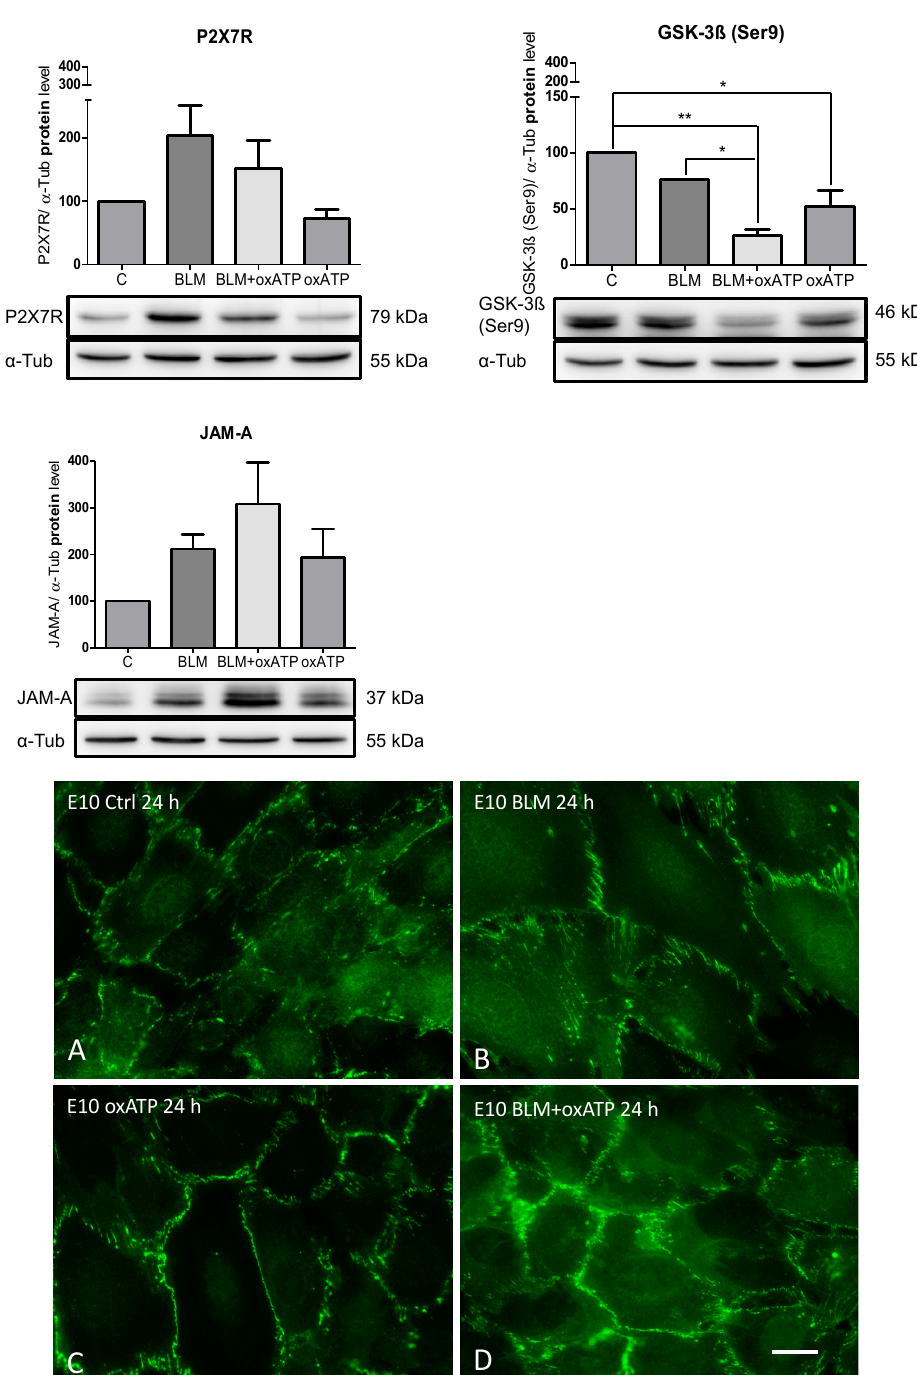
Figure 4. Effects of P2X7R inhibition by 150 µM oxATP, which was added 2 h prior to 100 mU/mL BLM treatment. Equal protein amounts of cell lysates were used in SDS-PAGE and analyzed by Western blot. α -Tub served as the loading control. Untreated cells were used as the control and normalized to 100%. Representative blots from three independent experiments are shown. Charts are presented as the mean ± SEM ( n = 3) of P2X7R / α -Tub, GSK-3 β (Ser9) / α -Tub and JAM-A / α -Tub. P-values: P2X7R 0.0338; GSK-3 β (Ser9) 0.002; and JAM-A 0.05. Immunofluorescence demonstration of JAM-A in untreated ( A ), BLM ( B ), or oxATP ( C ) treated E10 cells. Note the increased cell size after BLM exposure ( B ), which was ameliorated after oxATP ( D ). Representative images of multiple experiments ( n = 3) are shown. Bar = 20 µ m. * p < 0.05, ** p <